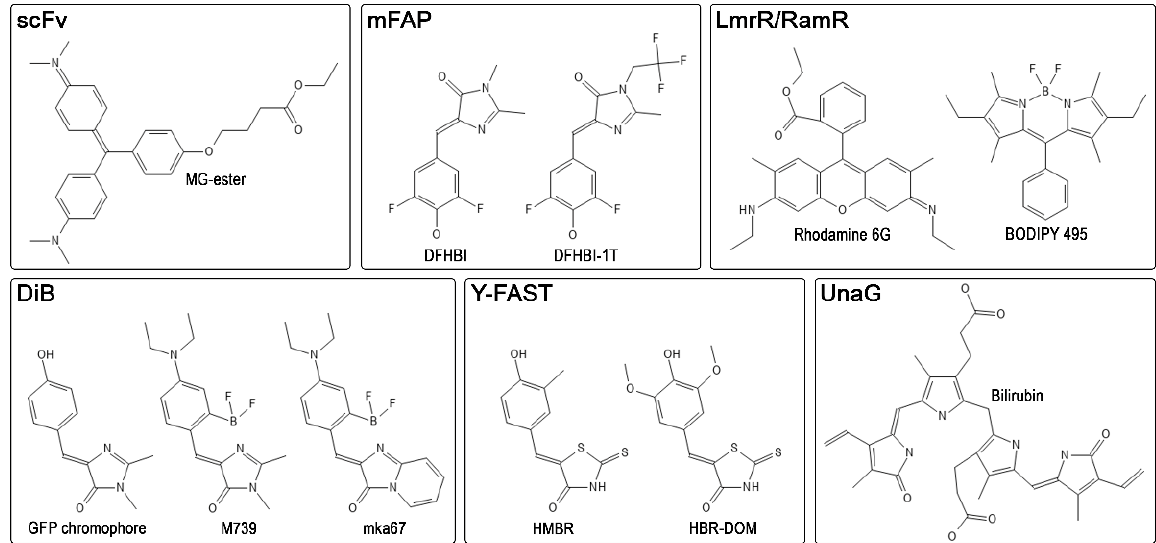
Figure 3. Common representatives of ligands for known FAP-based labeling systems. MG-ester—malachite green ester, DFHBI—difluoro-4-hydroxybenzylidene imidazolinone, DFHBI-1T—3,5-difluoro-4-hydroxybenzylidene-2,2,2-trifluoroethyl imidazolinone, BODIPY—4,4-difluoro-4-bora-3a,4a-diaza-s-indacene, HMBR—4-hydroxy-3-methylbenzylidene rhodanine, HBR-DOM—4-hydroxy-3,5-dimethoxybenzylidene rhodanine.